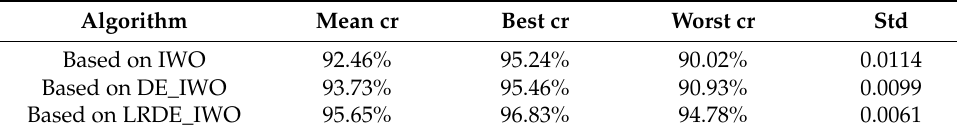
Table 2. Comparison of the results in the 20 m × 20 m area and 24 nodes. Table 4. Comparison of the results in the 100 m × 100 m area and 80 nodes.